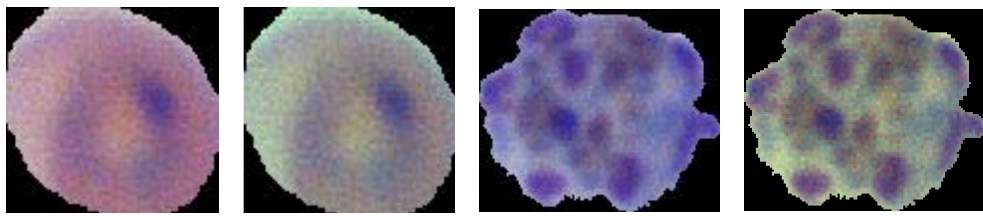
Figure 4. Examples of MP-IDB-FC images, before and after preprocessing